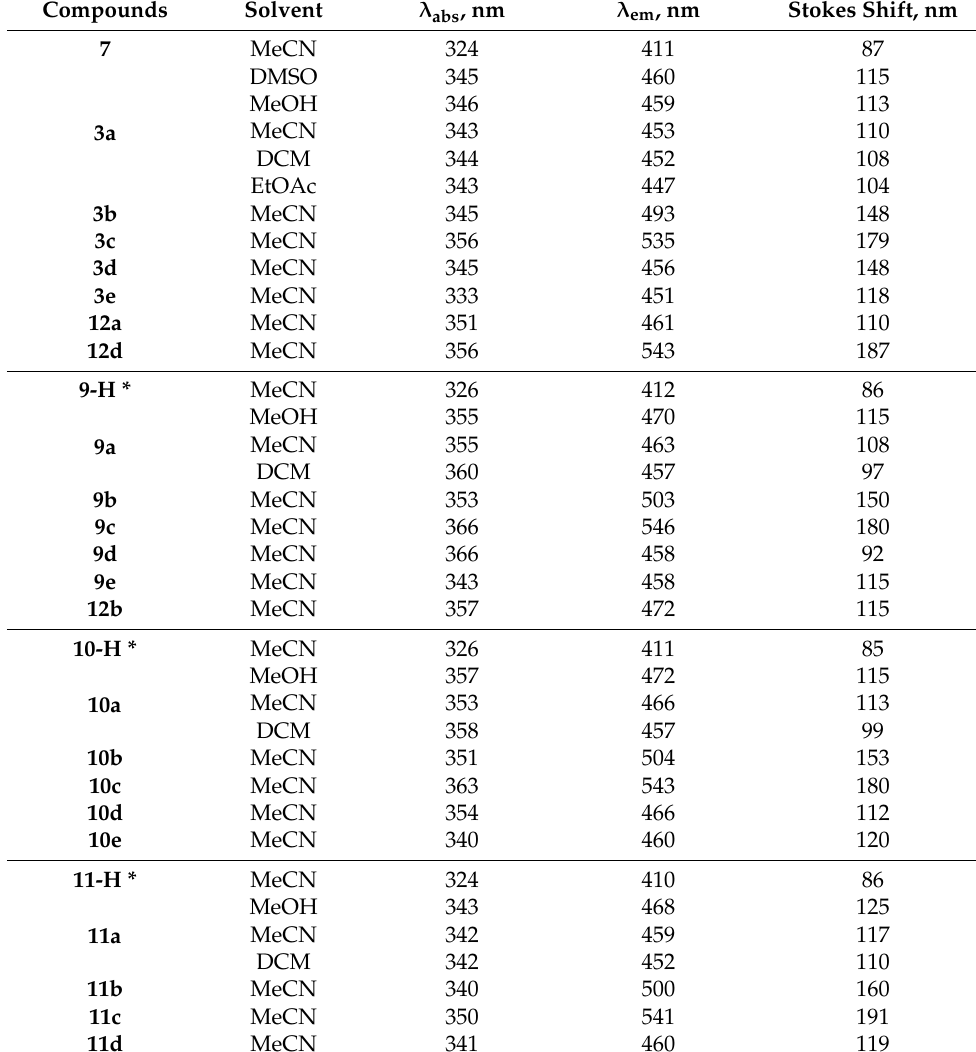
Table 7. Photophysical data of the coumarin derivatives.